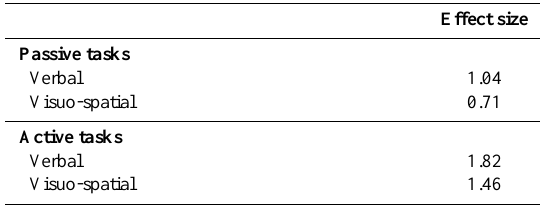
Table 1 Measures of effect size of the main effect of group in the four tasks. Values are calculated following Cohen’s method [5] as reported in